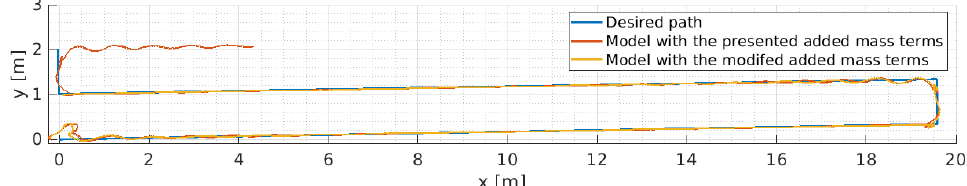
Figure 10. Simulation results for path following employing the modified controller with added mass terms multiplied by a factor of 0.5.